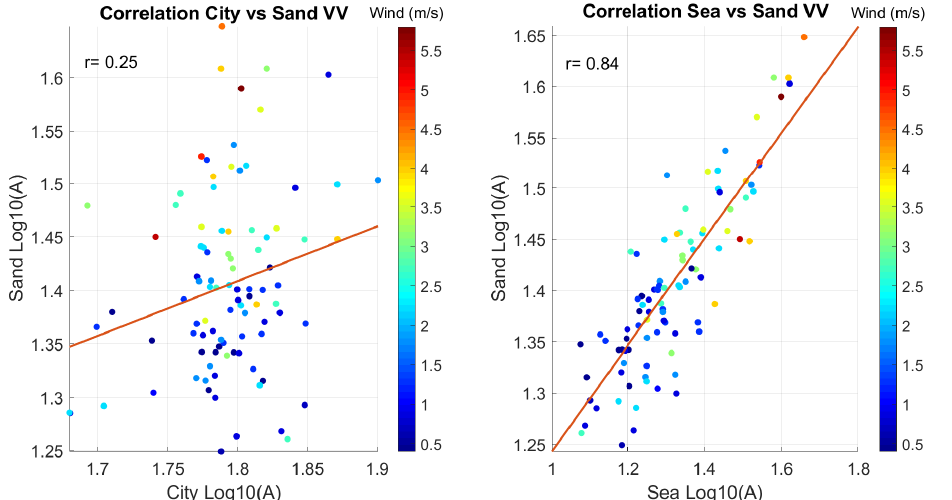
Figure 4. Correlation factor between pairs of masks. The color bar represents the wind intensity. Left : correlation factor between city and sand masks (VV polarization). Amplitude values of the city area and of the sand area are poorly correlated. Right : a high correlation occurs between the sand and sea masks. The hypothesis is that they are influenced by the phenomenon, i.e., wind. As the color bar shows, there no clear correlation between environmental factors (such as wind) and the city mask, whilst the wind intensity has a more relevant influence on the sand and sea